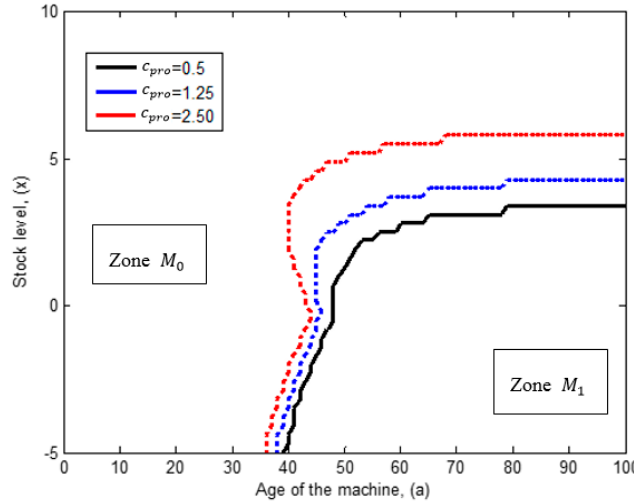
Figure 13. Sensitivity of the production cost on the repair/major maintenance policy.